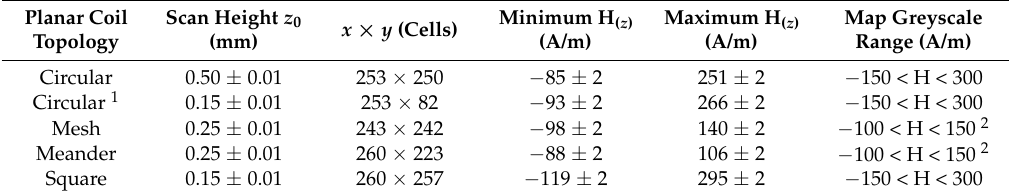
Table 1. The scan height ( z 0 ) and minimum and maximum measured field strengths, H , above each ( z ) of the four planar coil topologies when energized to draw 0.40 A ± 0.01 A. The common greyscale ranges 2 allow for a better comparison between the resulting magnetic field maps. The mean time taken to scan one cell is 1.414 seconds; the mean scan time for each topology is 24.23 hours. Planar Coil Scan Height z 0 Minimum H ( z ) Maximum H ( z ) Map Greyscale x × y (Cells) Topology (mm) (A/m) (A/m) Range (A/m) Circular 0.50 ±